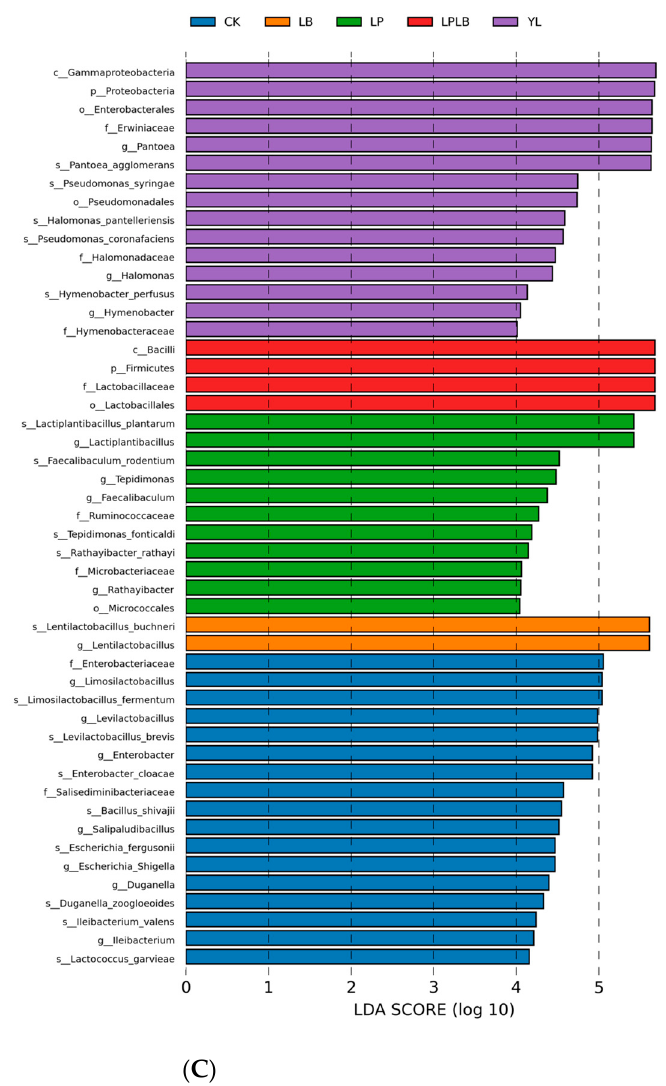
Figure 2. Differences in bacterial taxa and bacterial abundance at phylum and genus level of native grass silage. CK, control group; LP, Lactobacillus plantarum ; LB, Lactobacillus buchneri ; PB, Lactobacillus plantarum + Lactobacillus buchneri . The bacterial communities are shown at the phylum level ( A ) and the genus level ( B ). Differences in bacterial taxa were revealed using LEfSe analysis ( C ).